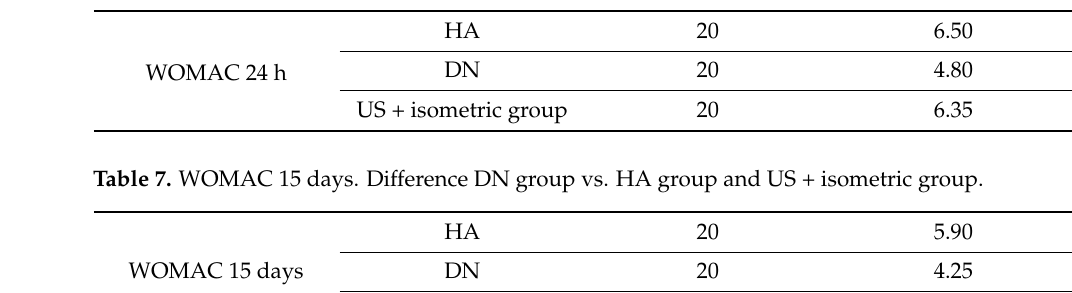
Table 6. WOMAC 24 h. Difference DN group vs. HA group and US + isometric group.